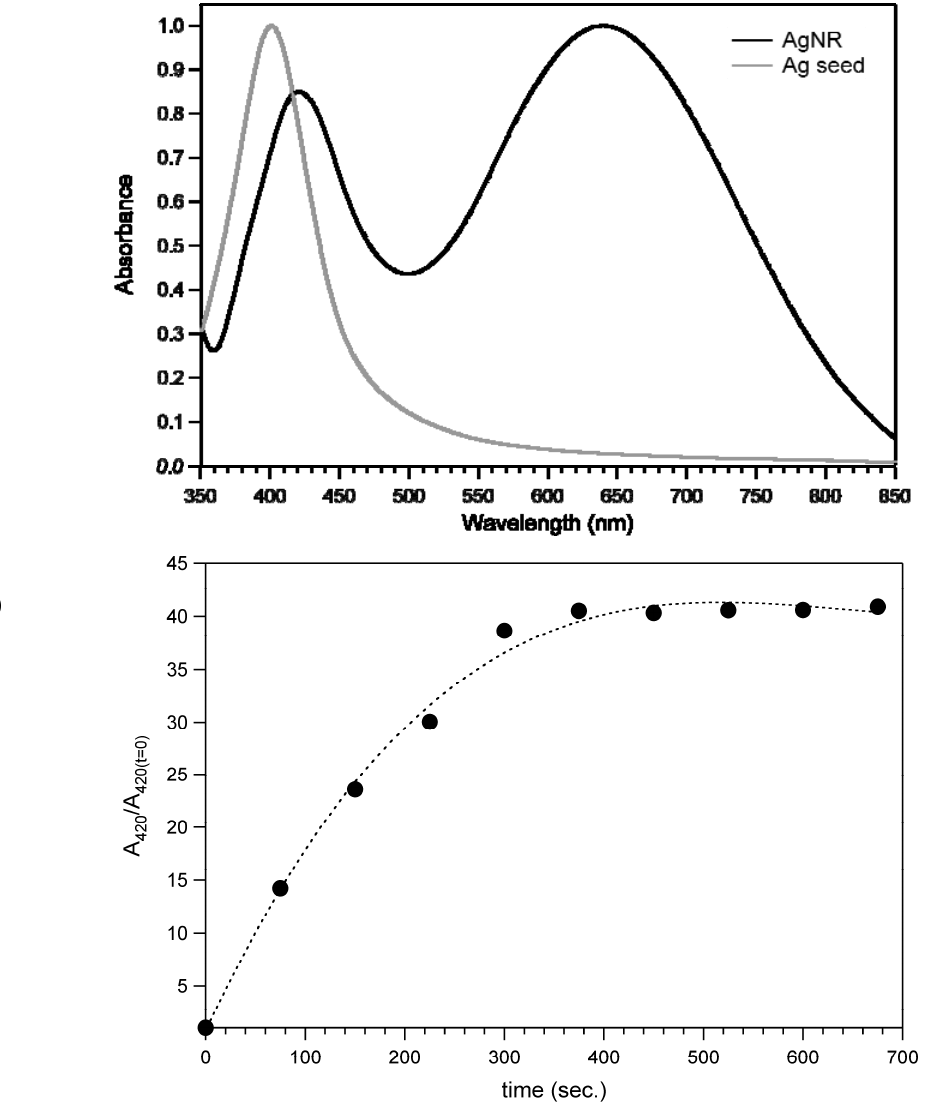
Figure 2. (a) UV-Vis absorption spectra of silver seed (grey) and nanorods (black) water dispersions. (b) Plot of the nanorods absorbance at 420 nm as a function of the reaction time with reference to the absorbance recorded at t =